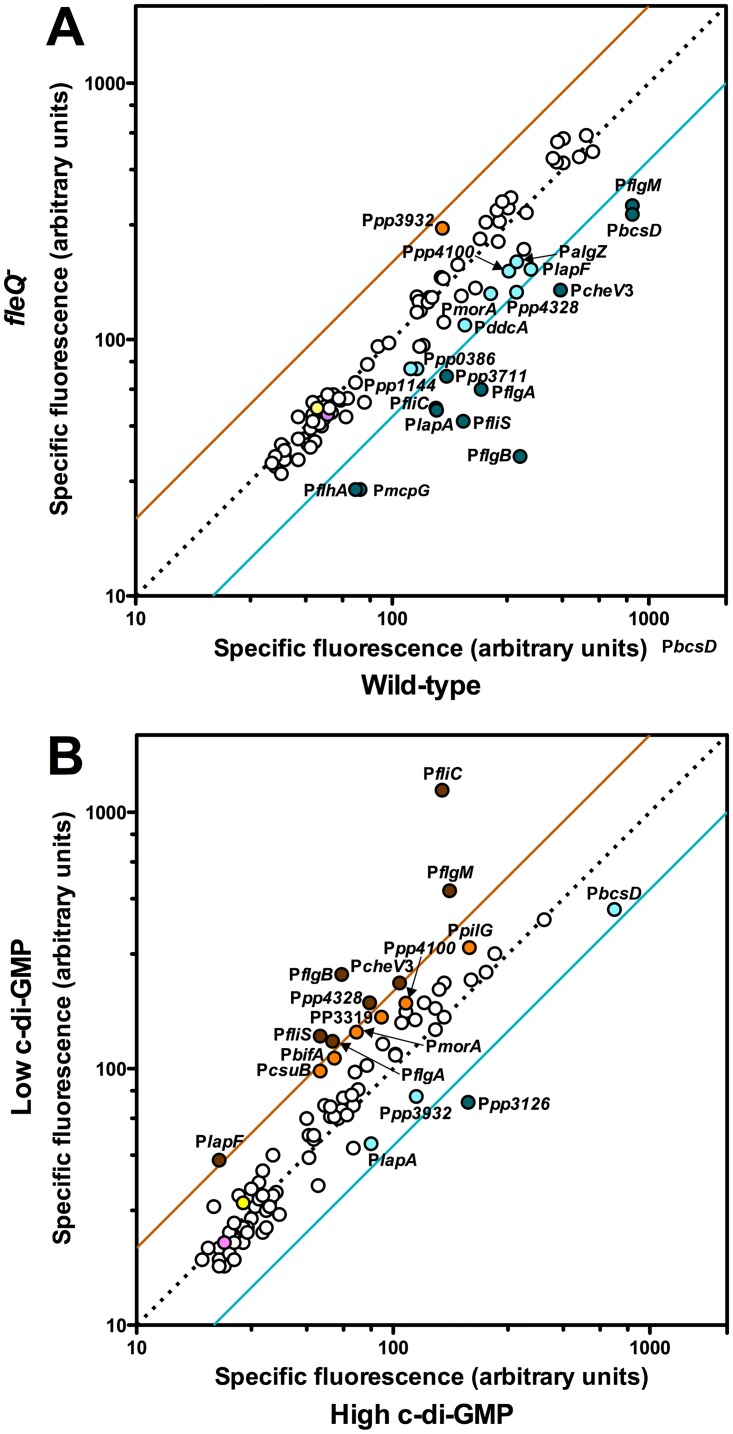
Screenings of the ordered promoter library for FleQ and c-di-GMP regulation.Diagonal plots showing expression of each promoter fusion in the fleQ (MRB35) vs. wild-type (KT2442) backgrounds (A), or in the presence of low vs. high levels of c-di-GMP (B). Red and blue lines represent 2-fold differential expression. Data points showing over 2-fold differential expression are shown in dark red or dark blue. Data points showing over differential expression greater than 1.5-fold but lower than 2-fold are shown in orange or cyan. Data from the experimental controls (KT2442 and KT2442 bearing the empty vector pMRB1) are shown in yellow and pink,respectively. Promoters selected for confirmation are indicated in each plot. The original data for these plots are shown in S2 Table.